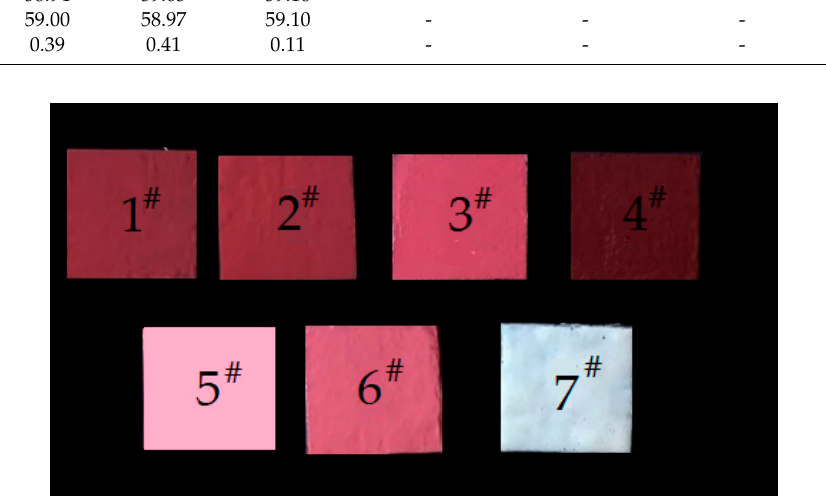
Figure 7. Coating